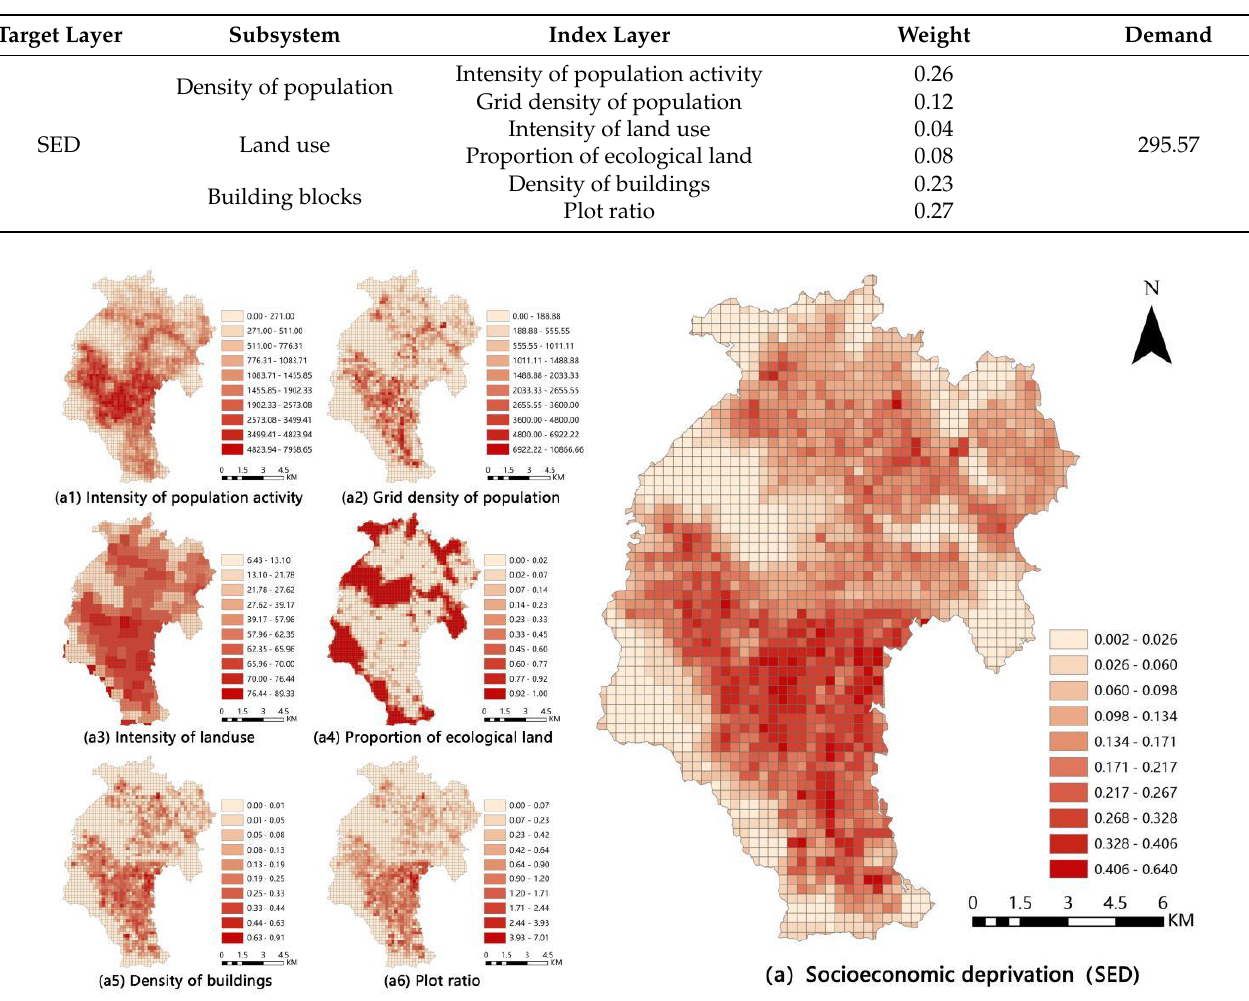
Figure 6. Socioeconomic deprivation (SED) indexes.